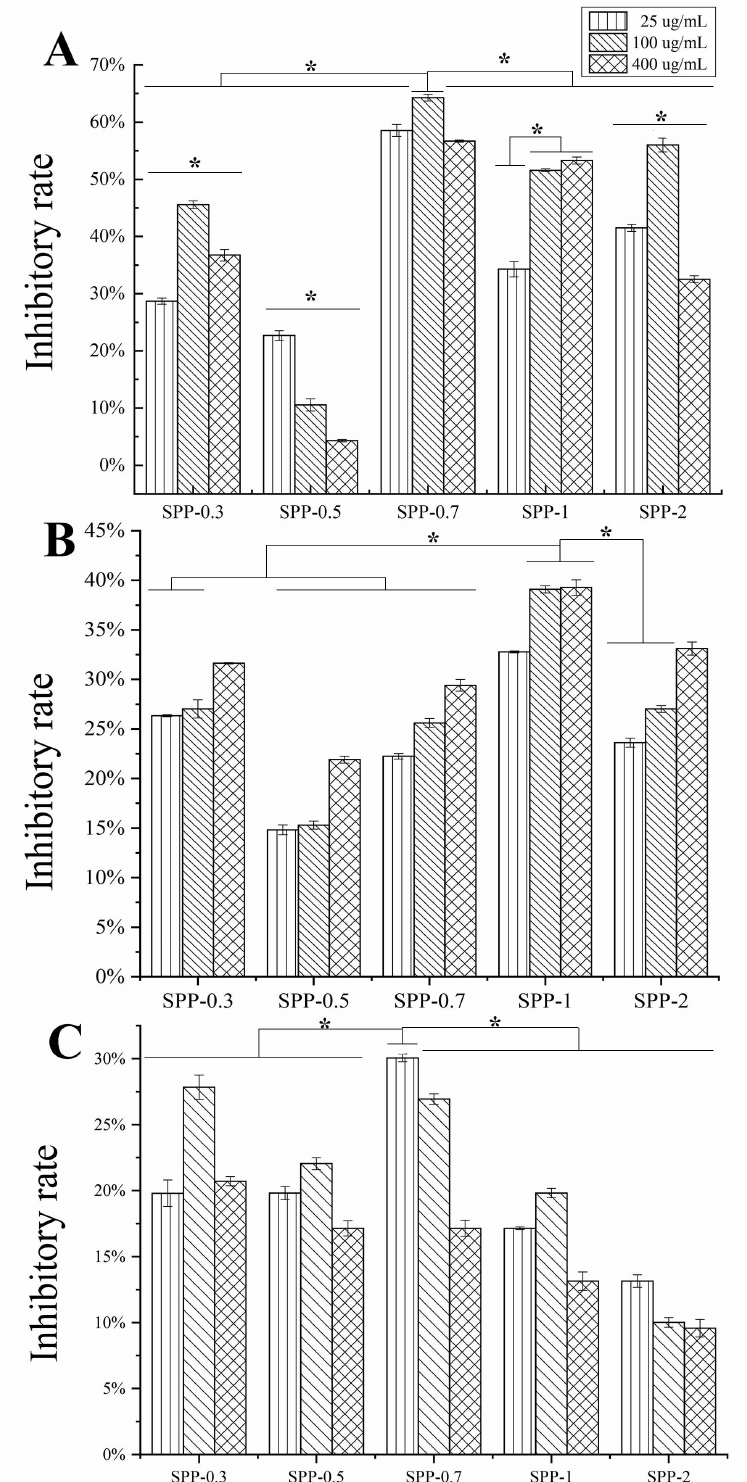
Figure 2. Inhibitory effects of five polysaccharide fractions with different concentrations (25, 100, and 400 µ g/mL) on proliferation of A549 ( A ), HepG2 ( B ) and B16 ( C ) cells (mean ± SD). The asterisk (*) on the bars indicated the significance difference ( p <0.05) between the inhibitory rate of each group according to one-way ANOVA